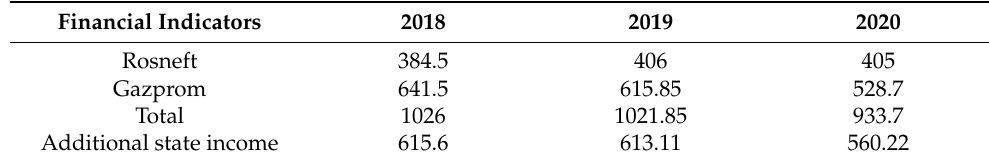
Table 6. Additional state income, billion